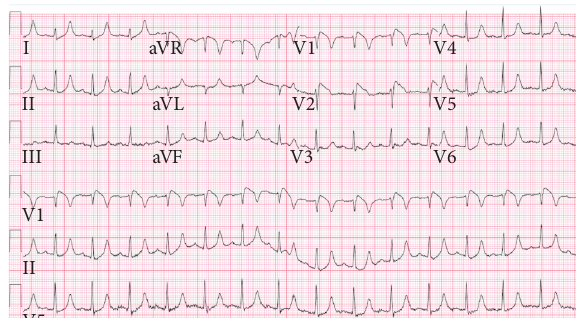
Figure 1: ECG on presentation showing ≥ 2mm “coved type” ST elevation and a T-wave inversion in precordial leads V1 and V2 (type 1 Brugada pattern). Axis is normal and QRS are not widened.